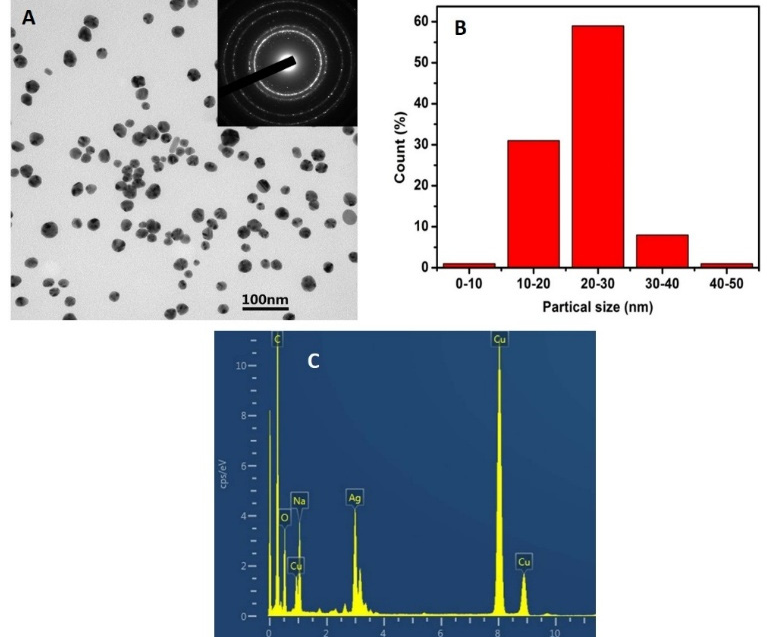
Figure 4. ( A ) TEM images (inset: SAED pattern), ( B ) size distribution, and ( C ) EDS spectrum of CMS/AgNPs.